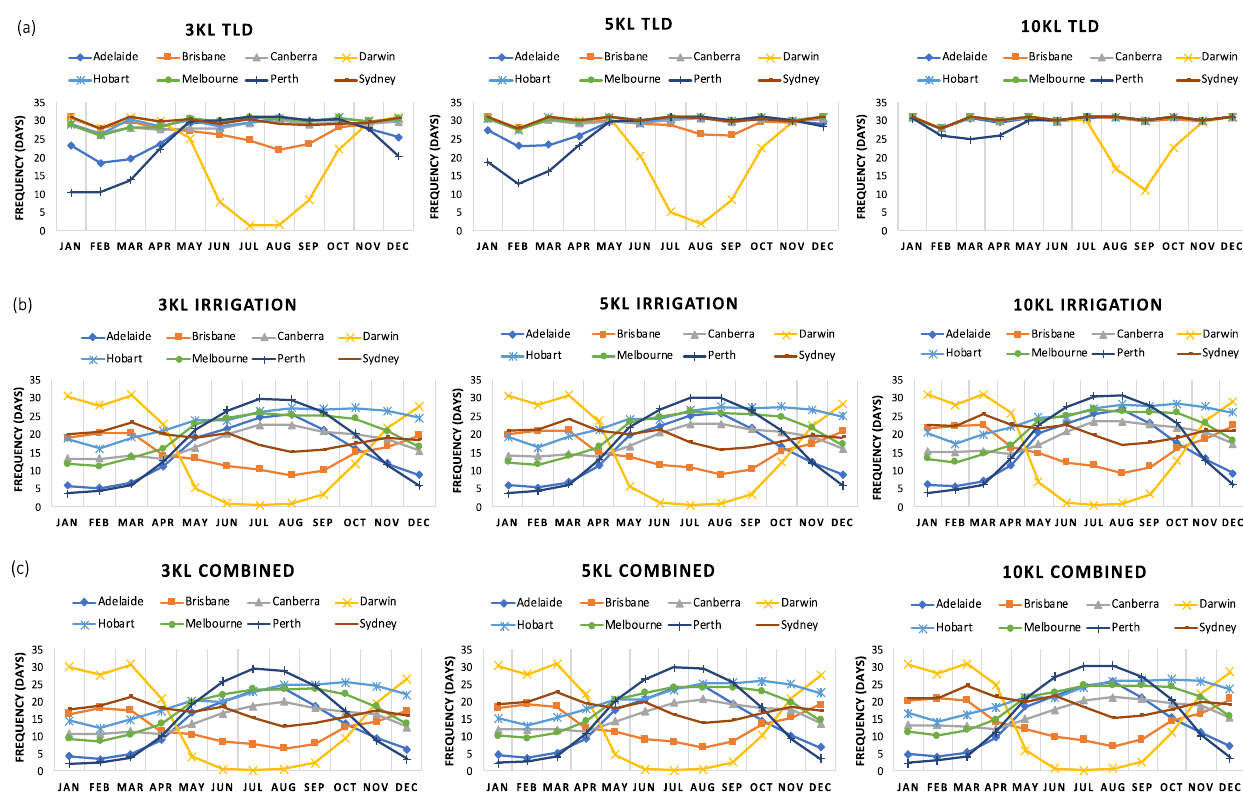
Figure 10. Charts showing number of days when monthly water demand is met for 3, 5 and 10 m 3 rainwater tanks for three different water demands: ( a ) TLD use; ( b ) irrigation use; ( c ) combined use.